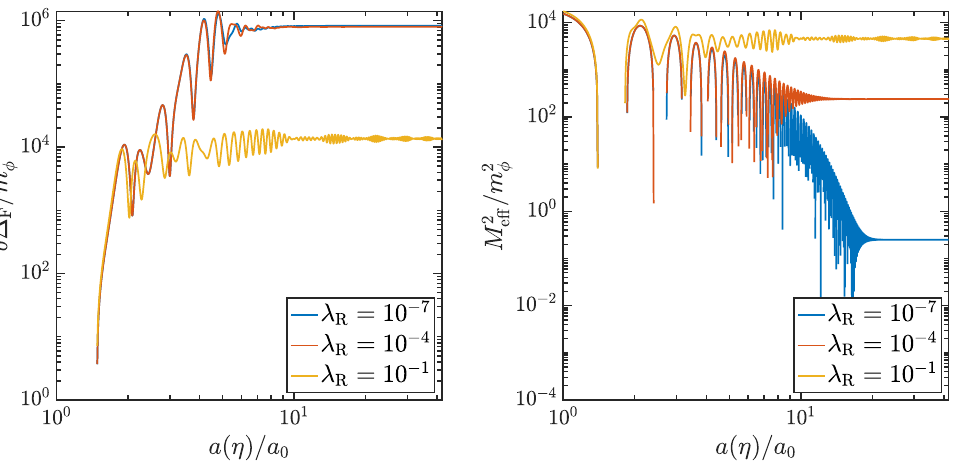
Figure 6 . The two-point function δ ∆ F (left panel) and the effective mass function M 2 panel). The results are shown for λ R ∈ { 10 − 7 , 10 − 4 , 10 − 1 } , ¯ ξ R = 50 and Γ ' 0 . 1 H 0